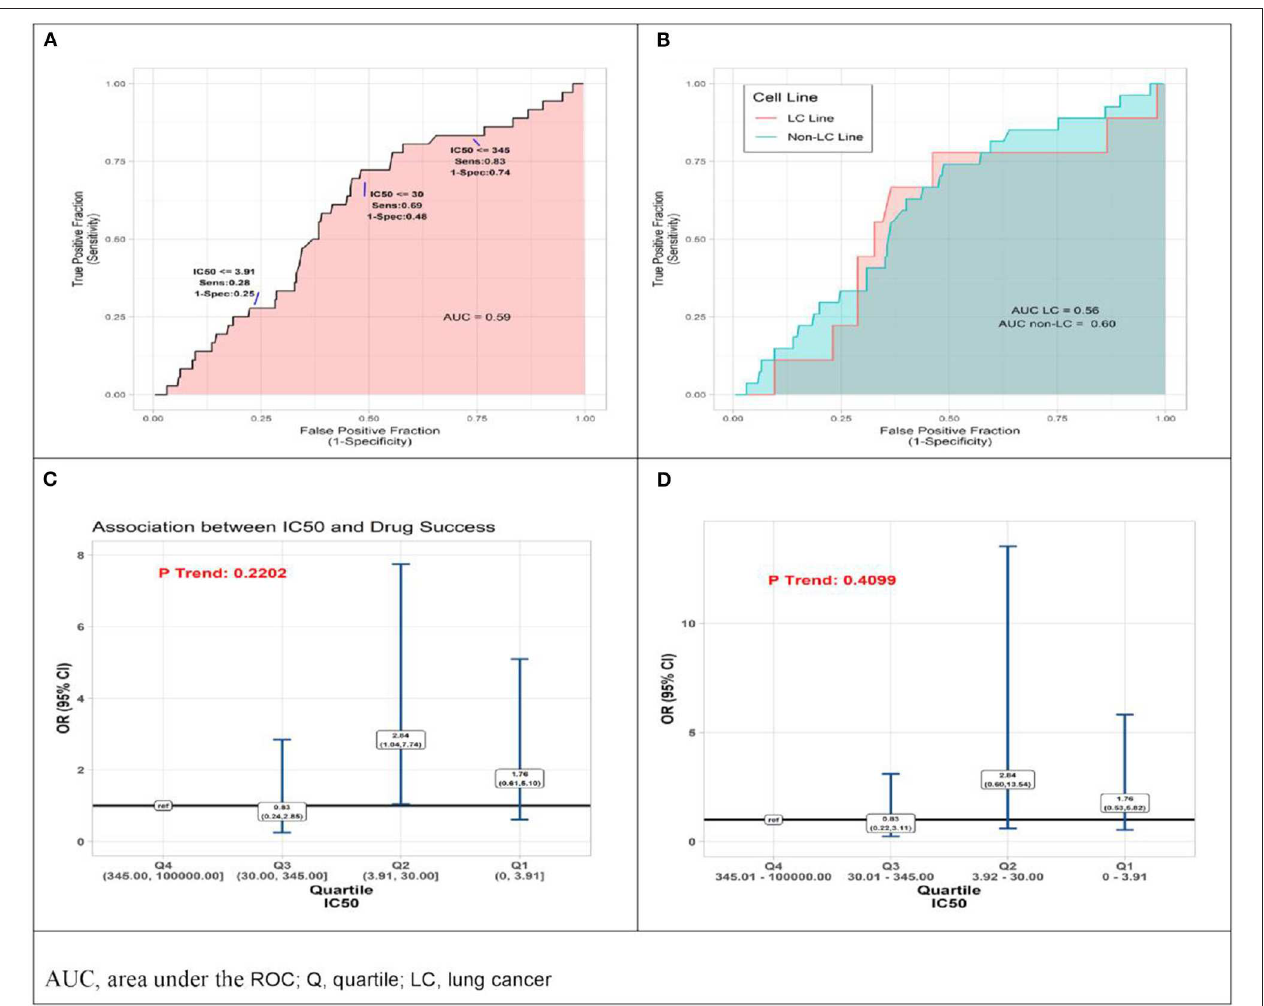
FIGURE 2 | Results of quantitative analyses of preclinical cell line experiments. (A) Receiver operator curves (ROC) displaying accuracy of IC50 value as predictor of drug approval for all cell line experiments combined, and (B) within subsets defined by type of cell line, lung cancer cell lines (pink) non-lung cancer cell lines (aqua). (C) Odds Ratio (OR) associations between drug success and quartile of IC50 result of preclinical cell model experiment, drugs with IC50 in lower quartiles (Q) Q1, Q2, Q3 compared to those with IC50 in highest quartile, Q4 (reference) by two analytic methods, conventional logistic regression, and (D) General Estimating Equation (GEE), allowing for non-independence of multiple experiments using the same